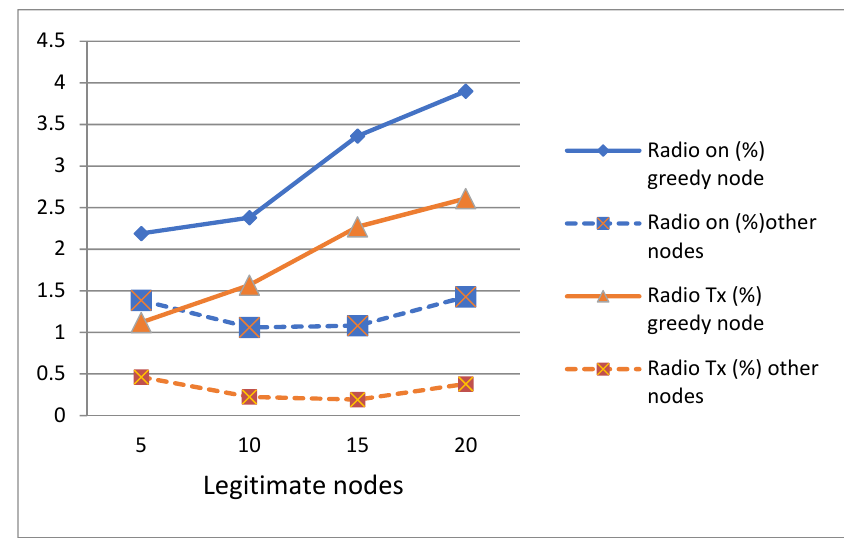
Figure 5. Radio on and radio Tx of greedy and legitimate nodes.